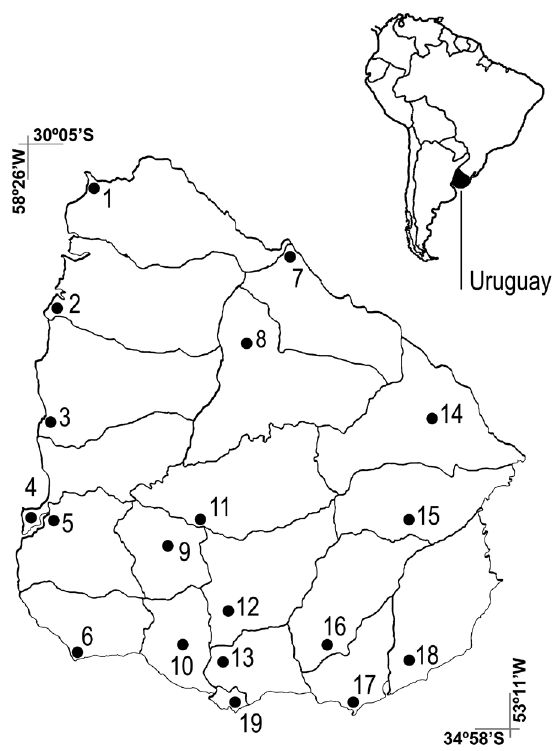
Figure 1. Map of Uruguay showing the cities from which the samples (1-19) were taken. (1 Bella Unión, 2 Salto, 3 Paysandú, 4 Río Negro, 5 Mercedes, 6 Colonia del Sacramento, 7 Rivera, 8 Tacuarembó, 9 Trinidad, 10 San José de Mayo, 11 Durazno, 12 Florida, 13 Canelones, 14 Melo,